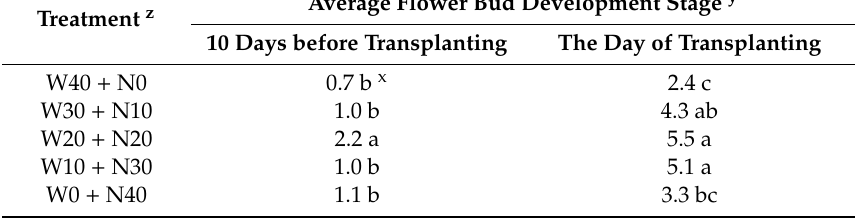
Table 1. Average flower bud development stages on the apical meristem of “Maehyang” strawberry runner plants affected by the nutrient solution resupply period at 10 days before transplanting and on the day of transplanting ( n = 12).